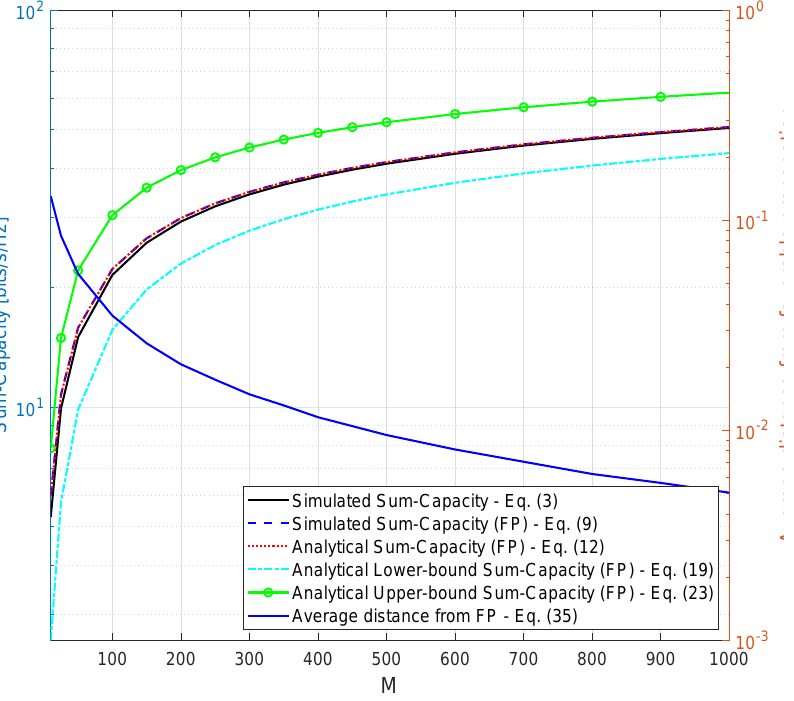
Figure 2. Simulation considering K = 10, ρ = 80 [dB], R = 100 [m], R min = 10 [m], and λ = 0.01070687